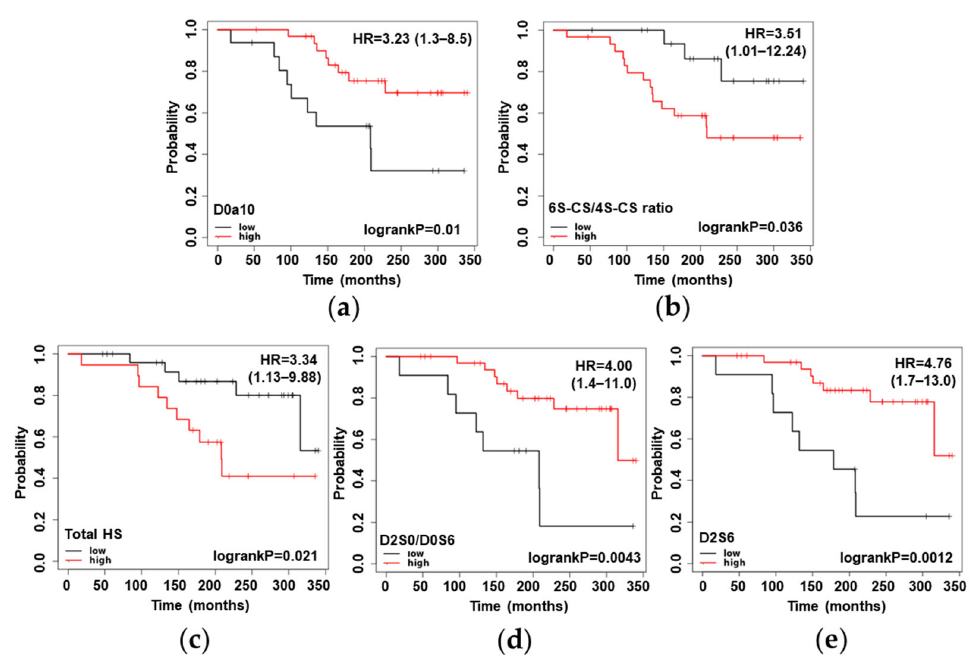
Figure 6. Kaplan–Meier plots of radical prostatectomy patients, based on the level of a given GAG motif: ( a ) D0a10 relative abundance; ( b ) 6S-CS/4S-CS ratio; ( c ) total HS abundance; ( d ) D2S0/D0S6 relative abundance; ( e ) D2S6 relative abundance. Low- and high-value groups were not further corrected for the Gleason score and pathological stage data. See Figure 1 for resolving the GAG structure